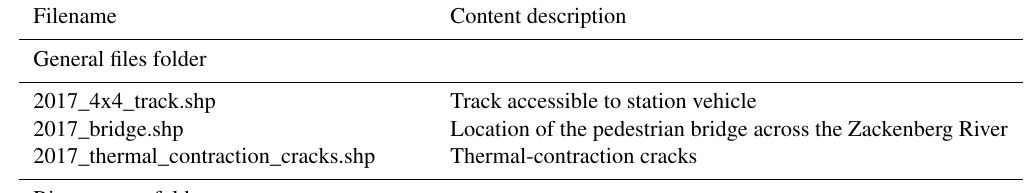
Table 2. List of filenames for corresponding dates and